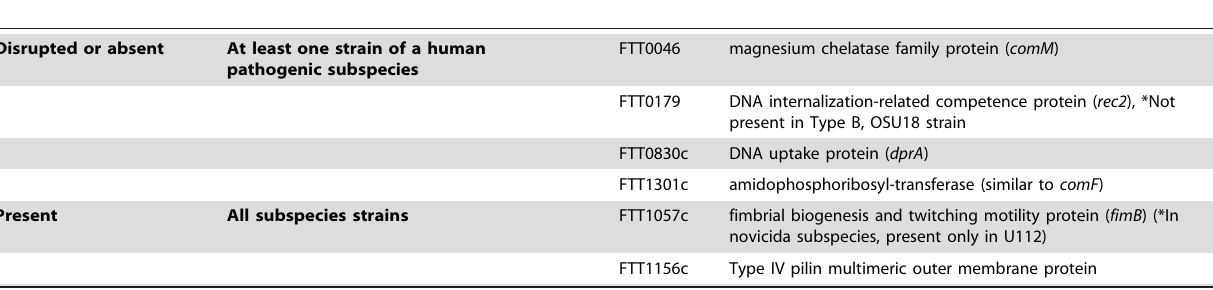
Table 6. Phylogenetic Differentiation Associated with Gain and Loss of Genes Regulating Competence (E values . 1e-10).